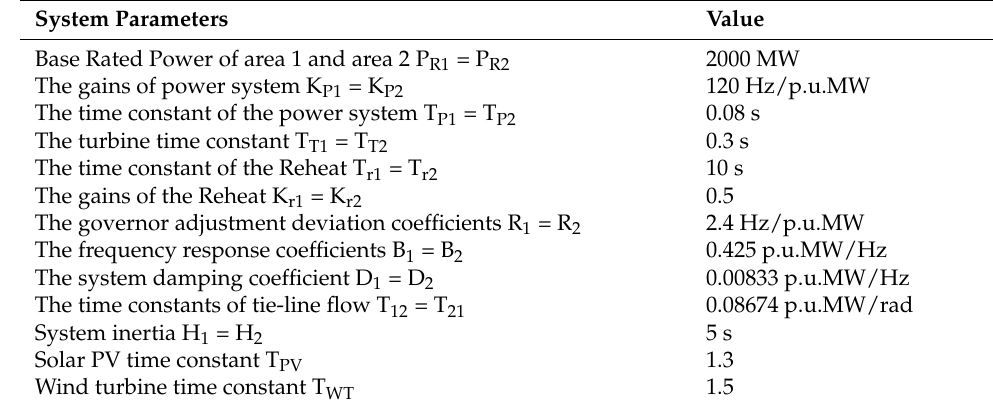
Table A1. The parameters of the proposed HPS and RERs.